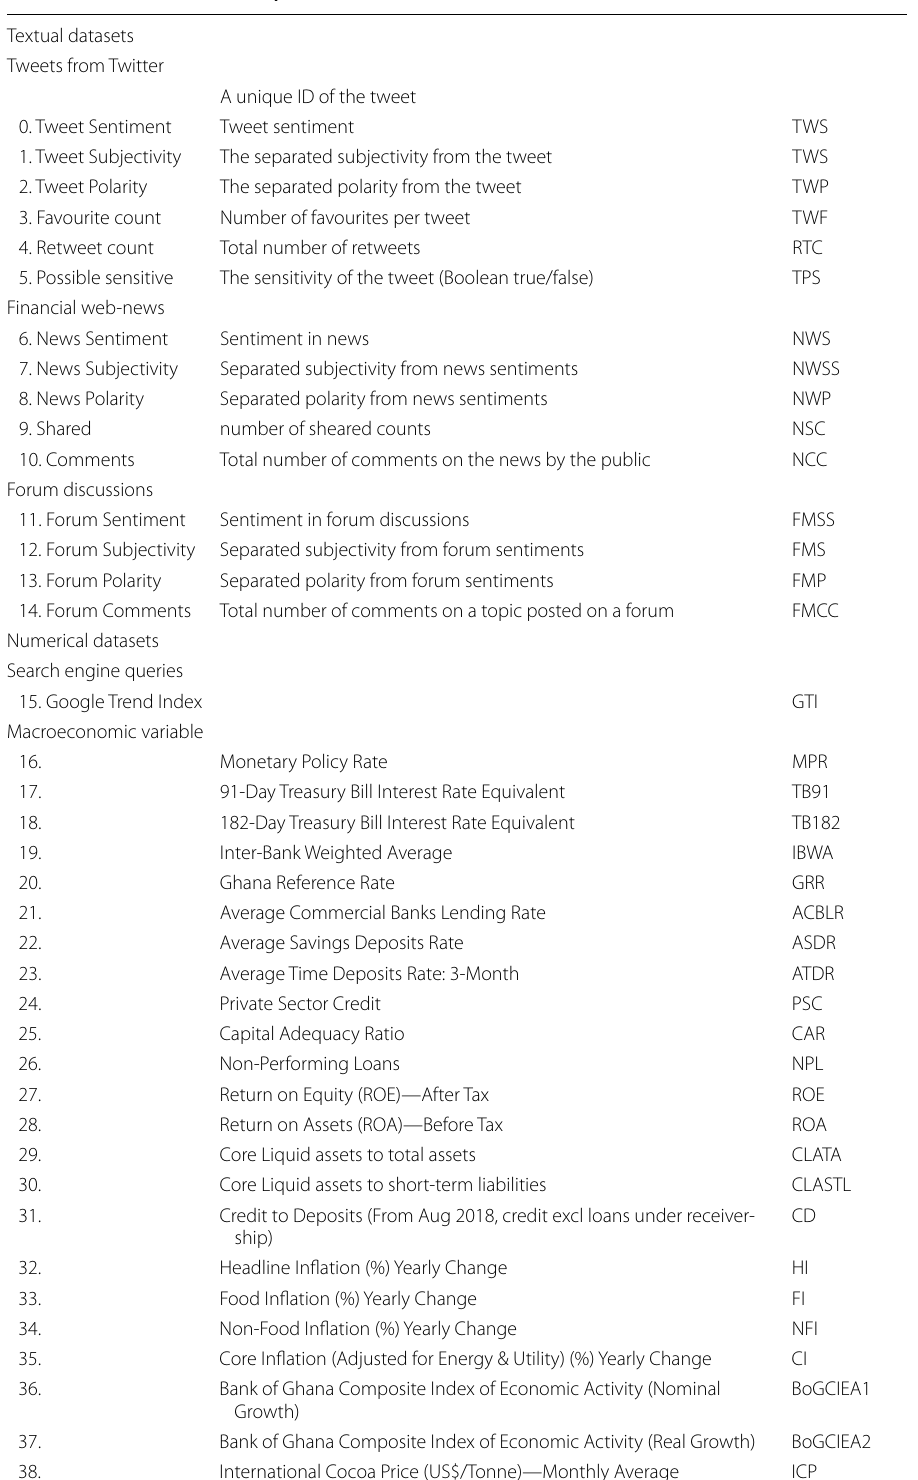
Table 6 Textual Datasets feature